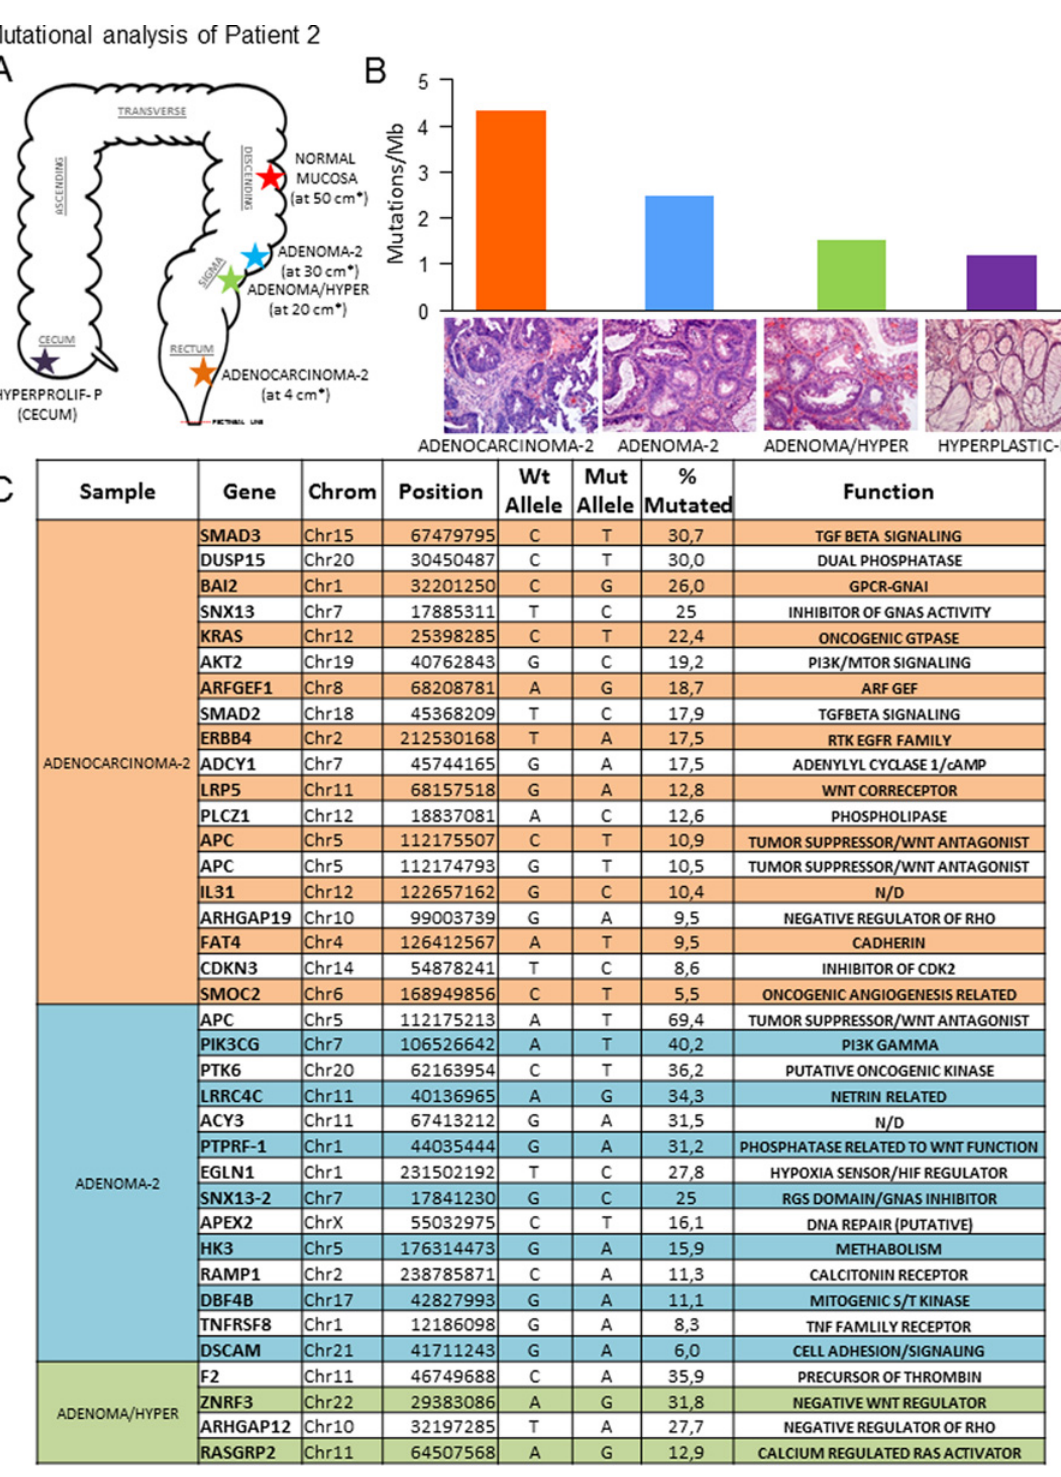
Fig 2. Mutation analysis of patient 2. A) Scheme showing an approximated representation of the location of each lesion analysed. The distance ( * , in cms) from the pectineal line (red dots) is shown. B) Mutational index (number of mutations/Mb) found in the indicated sample from the primary NGS analysis. H&E pictures are representative of each lesion studied by NGS. C) Validated mutations found in a secondary targeted NGS analysis of the indicated samples. Chrom: chromosome; % mutated: percentage of mutant nucleotide found in the corresponding gene within the same sample.